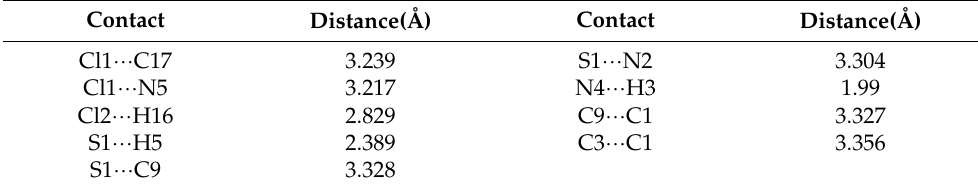
Table 5. Most important contacts and the corresponding shortest interaction